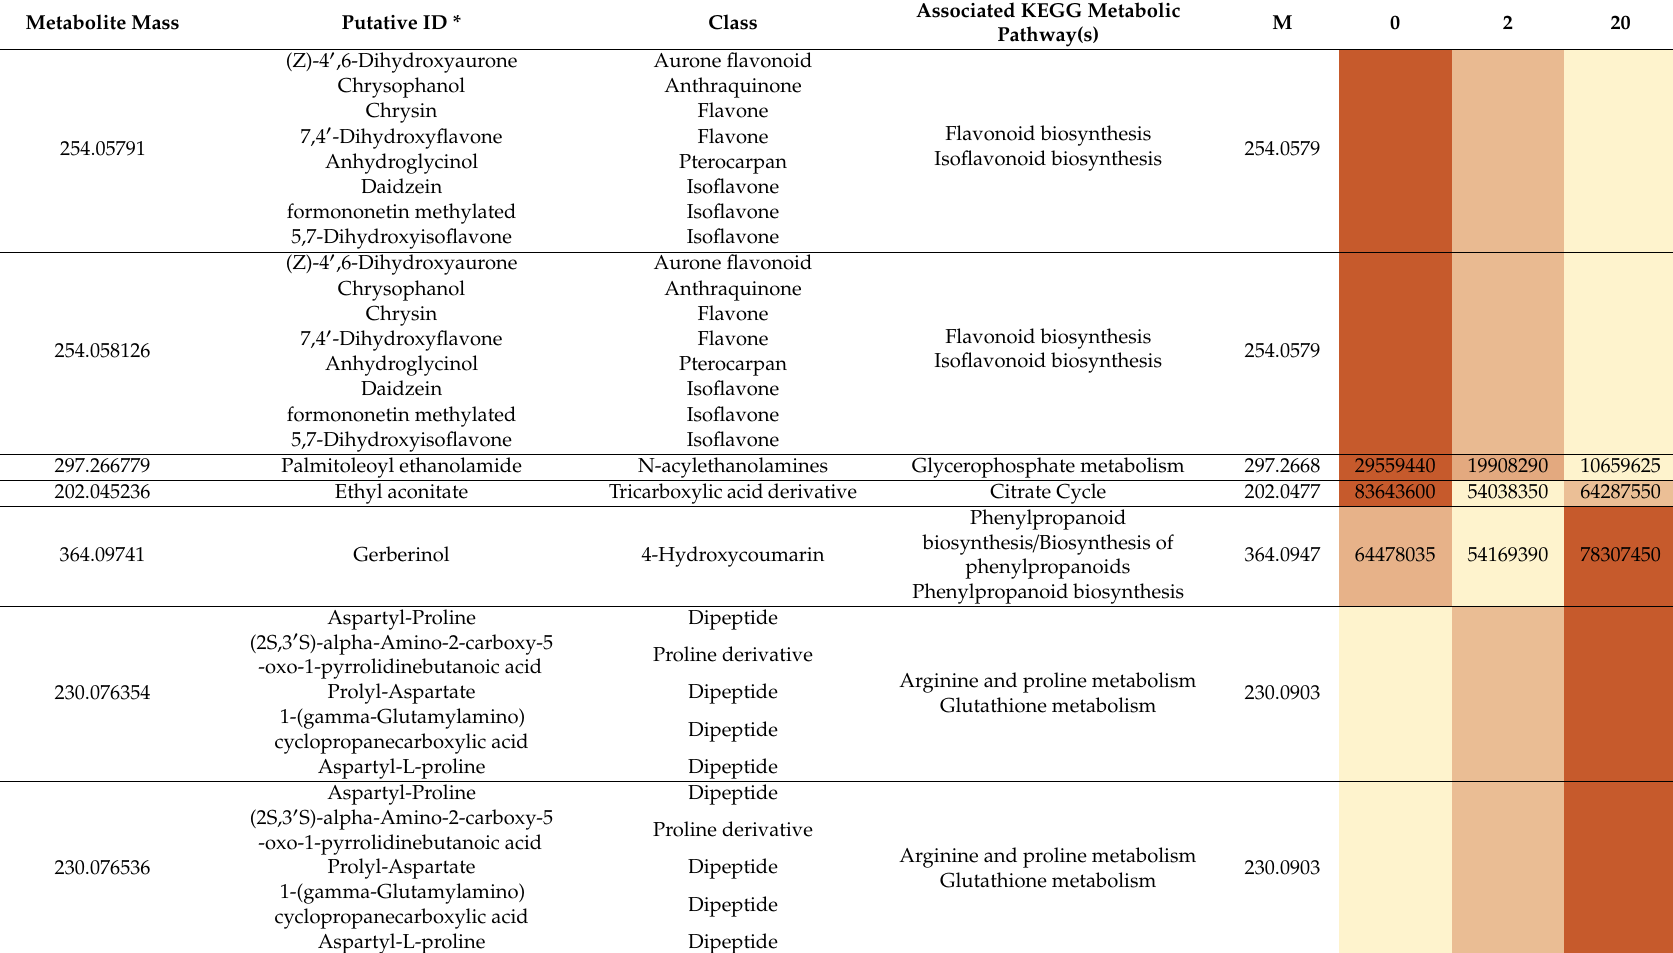
Table 1. Features identified as significant a modulated in response to thidiazuron treatment as compared to control according to partial least squares-discriminant analysis (PLS-DA) VIP Scores results. Metabolite mass is the predicted monoisotopic mass of the compound, M, monoisotopic mass is the known monoisotopic mass (as predicted by ChemSpider). Data is presented as mean ion intensity. Shading darkens with increasing